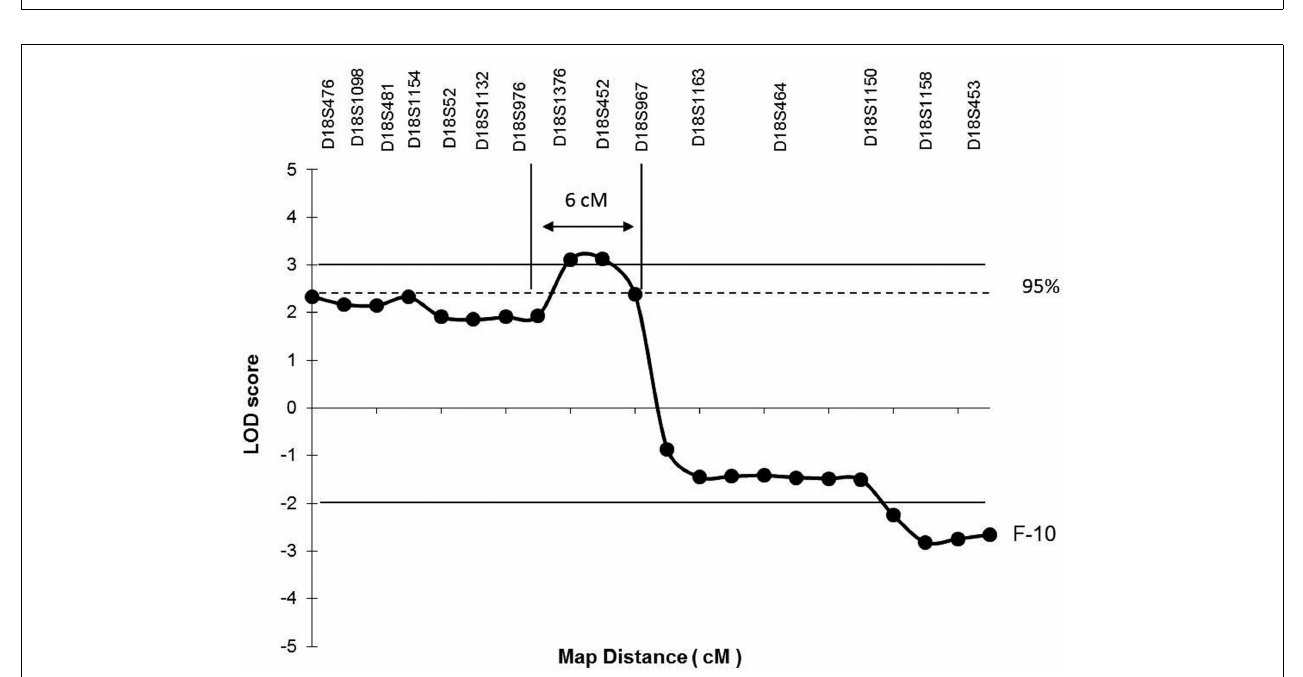
the 95% confidence interval calculated for the maximum LOD score achieved. Arrows between vertical lines identify the critical region (6cM) expected to contain the candidate gene flanked by markers at D18S967 and D18S976